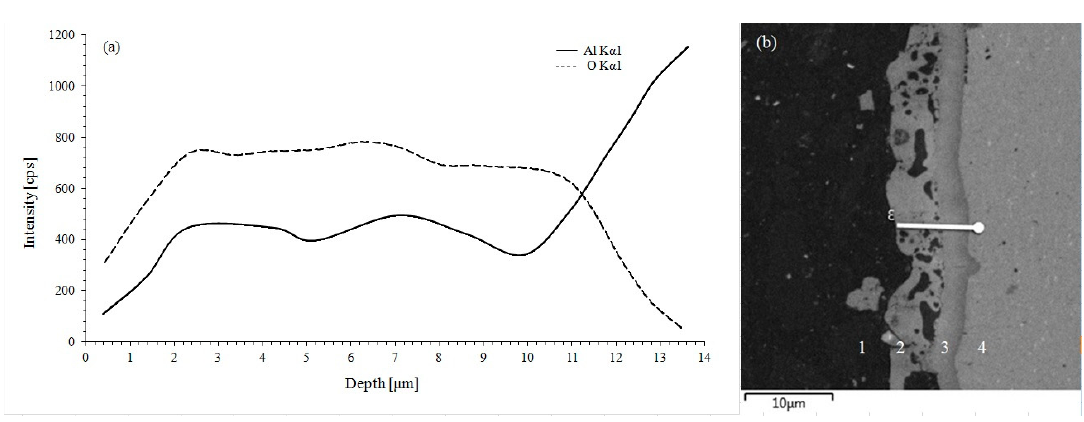
Figure 6. EDS line scan of the aluminum 1050 alloy cross section after PEO treatment and its microphotograph: 1: resin; 2: outer layer; 3: inner layer; 4: aluminum base.